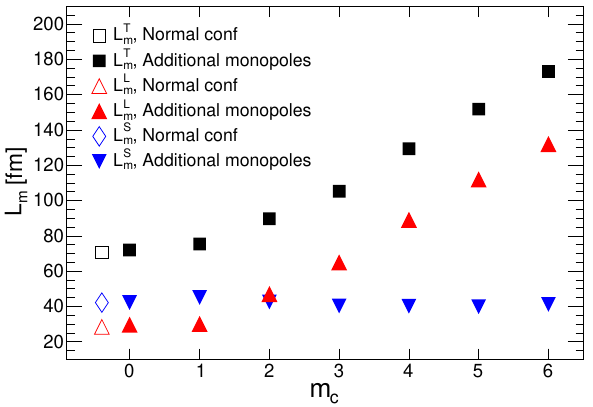
Figure 2 . The physical length of monopole loops L m versus the magnetic charges m c . L T and L S , which indicate the total length of the loops, the longest loops, and the shortest loops, m